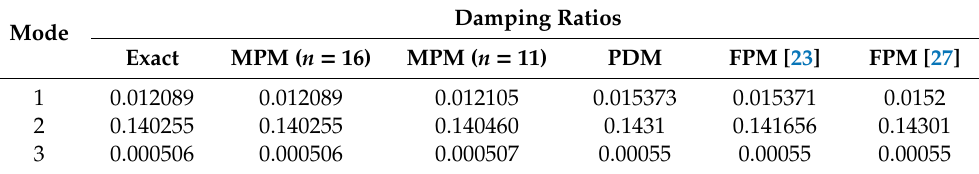
Table 5. The damping ratios of the frame system.